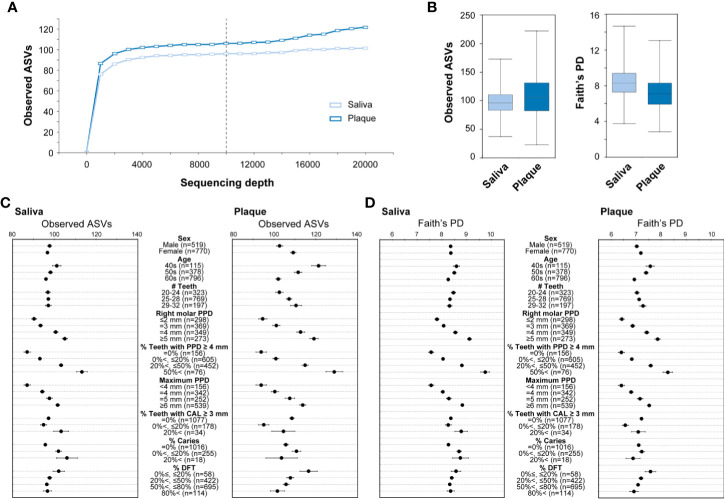
The α-diversity of the microbiota in saliva and plaque. (A) Rarefaction curves based on the observed ASVs. The colors indicate sample type: saliva (light blue) and plaque (blue). The vertical black dashed line indicates the 10,000-read rarefaction threshold. (B) The α-diversity in saliva and plaque. The box plots show two different indices: the number of observed ASVs (left) and Faith’s phylogenetic diversity (right). Data obtained from 1,289 participants in the TMM CommCohort Study and the TMM BirThree Cohort Study were analyzed and used for discovery and validation, respectively. (C, D) Number of observed ASVs (C) and Faith’s phylogenetic diversity (D) compared under the indicated conditions. The dots indicate the means; the error bars indicate the standard errors (SEs). PD, phylogenetic diversity; PPD, periodontal pocket depth; CAL, clinical attachment level; DFT, decayed and filled teeth.